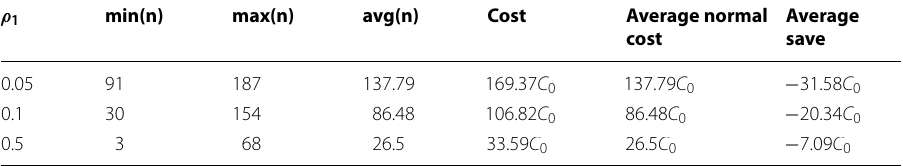
Table 2 The results of the second group of experiments ρ 1 min(n) max(n)